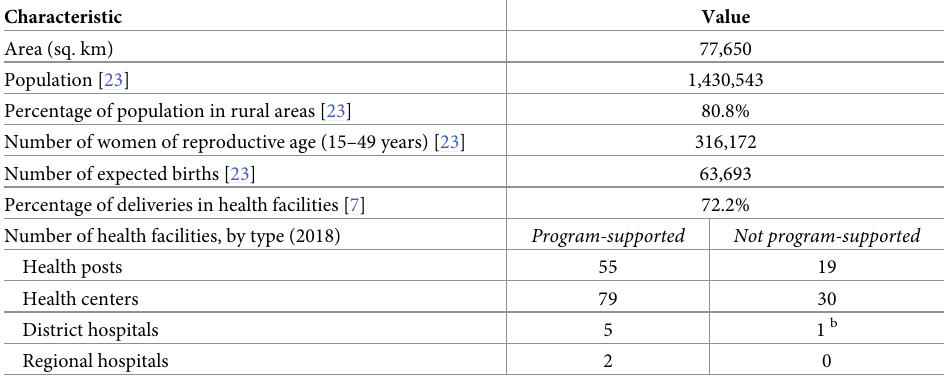
Table 2. Baseline characteristics of program setting a